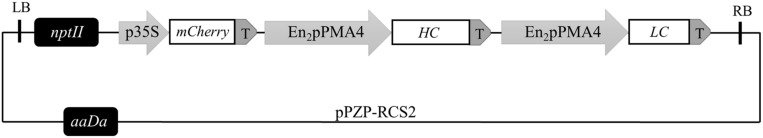
mCherry binary vector used for transformation of Nicotiana tabacum BY-2 cells mediated by Agrobacterium tumefaciens. T-DNA left and right borders are indicated by LB and RB, respectively; nptII, neomycin phosphotransferase II expression cassette; P35S, double-enhanced cauliflower mosaic virus 35S promoter; mCherry, coding sequence for the monomeric fluorescent protein mCherry; En2pPMA4, N. plumbaginifolia promoter (NpPMA4) reinforced by two copies of the CaMV 35S enhancer; HC, heavy chain; LC, light chain; T, nopaline synthase polyadenylation sequence (tNOS); aaDa, resistance gene to the aminoglycosides spectinomycin and streptomycin.